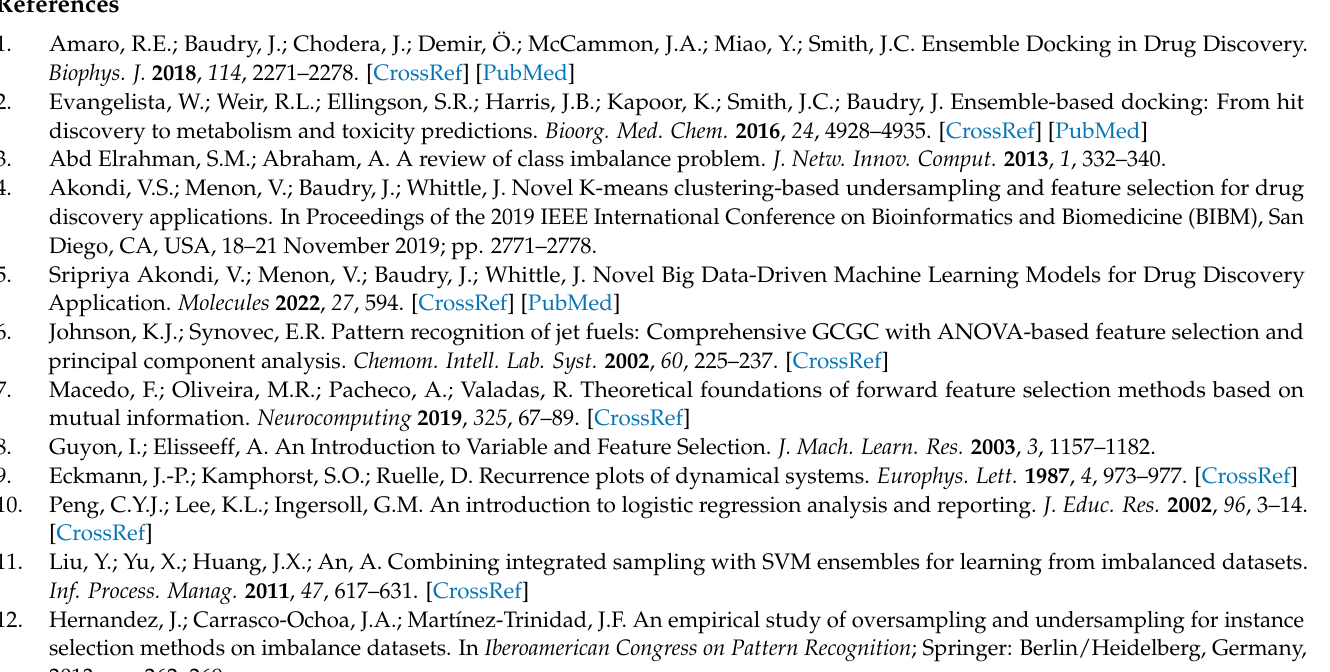
30%, Table S2: Classification table of ADRB2 with a training size of 30%, Table S3: Classification table of OPRK1 with a training size of